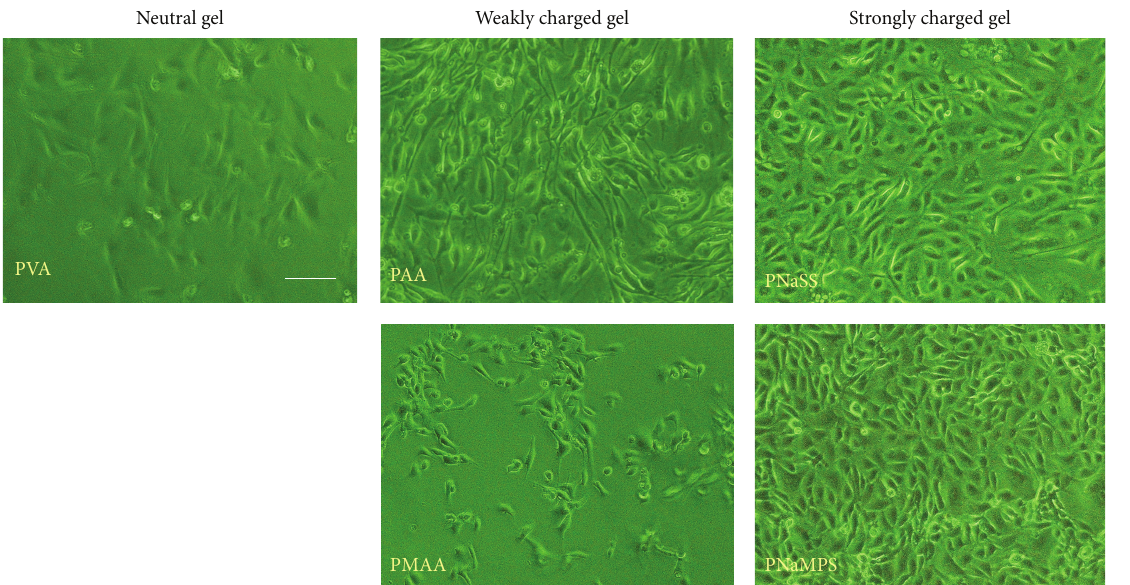
Figure 3: Phase-contrast micrographs of bovine fetal aorta endothelial cell (BFAECs) on various gels at a prolonged culture time (120h). Crosslinker concentration of gels: PVA (6 mol%), PAA (2mol%), PMAA (1mol%), PNaSS (10mol%), and PNaAMPS (6mol%). Original magnification: × 10. Scale bar: 100 𝜇 m. Reproduced with permission from [21]. © 2003, Elsevier, Inc.